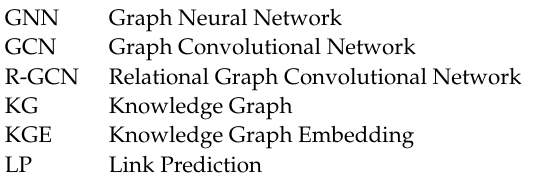
Table A1. Hyperparameters used to train the models in our work. ∗ marks the final picked values. B